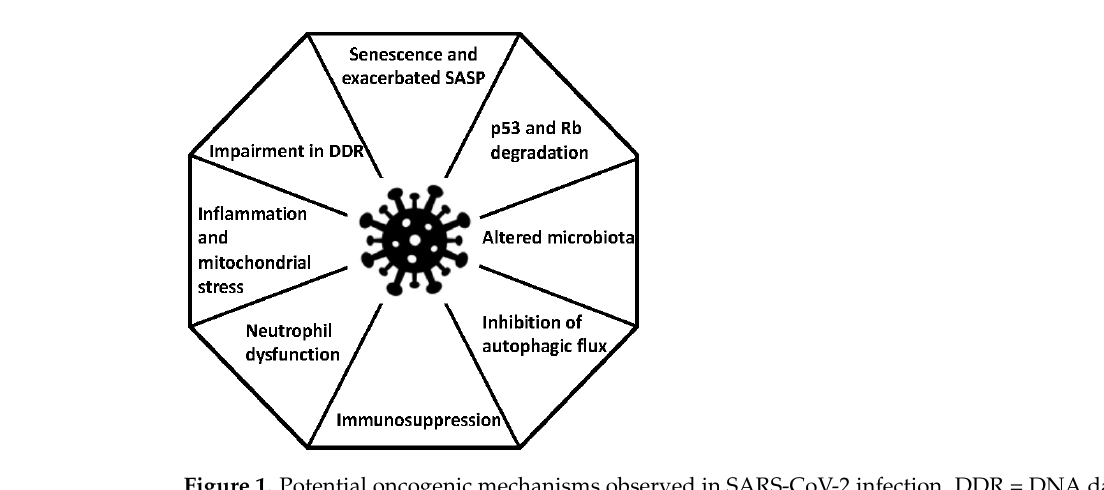
Figure 1. Potential oncogenic mechanisms observed in SARS-CoV-2 infection. DDR = DNA damage response; Rb = retinoblastoma protein; SASP = senescence-associated secretory phenotype.